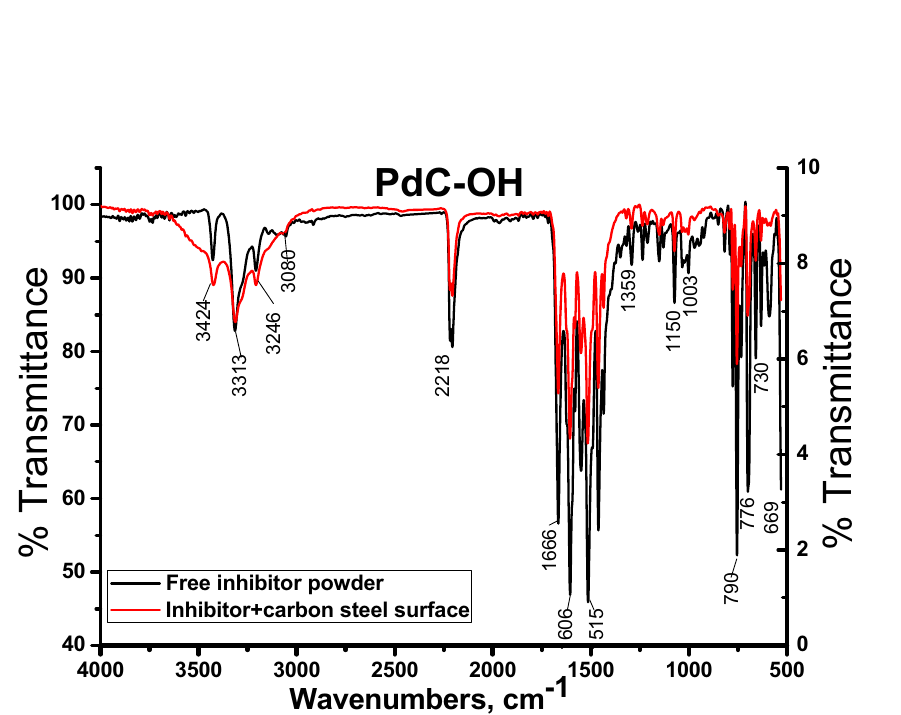
Figure 14. ATR-IR spectra of pure PdC-OH compound and carbon steel metal surface in 1 M HCl +